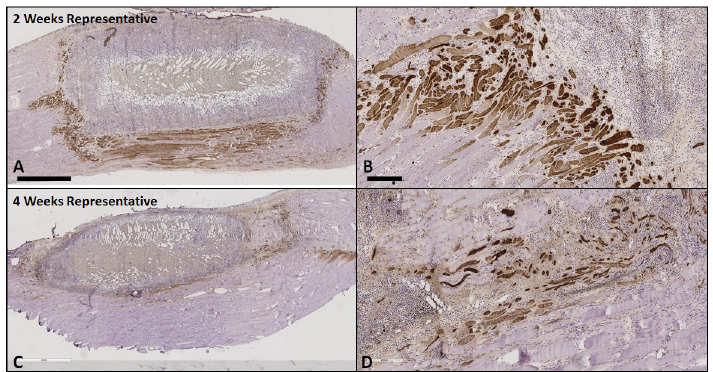
Fig 6. Represenative sections from a 2 week ( A and B , gel only) and 4 week ( C and D , gel only) TA muscle explantshowedthat embryonic myosin (f1.652+) was only observed in proximity to the edges but not within the defect, providing evidencefor regenerating host muscle fibers that were injuredduringsurgery but not neo-muscle formation in the defect. The density of f1.652+ fibers was observedto be higherat 2 weeks than 4 weeks. Scale bar = 2 mm in A and C. Scale bar = 200 μ m in B and D .